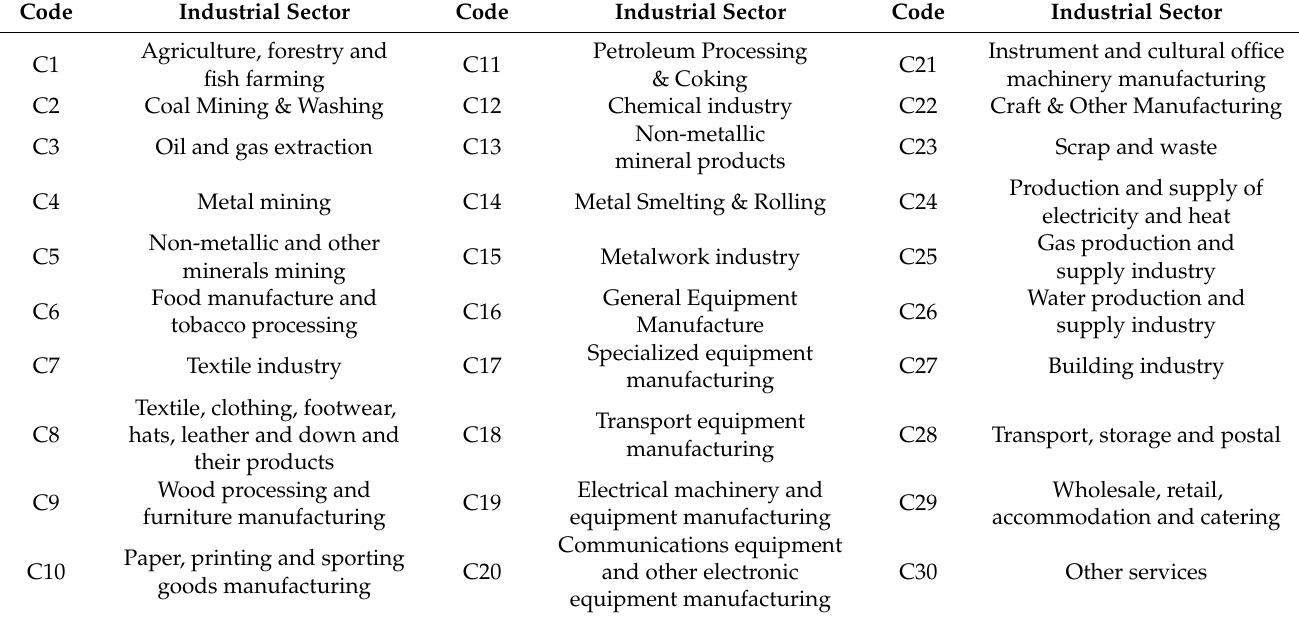
Table 1. Industry Sector